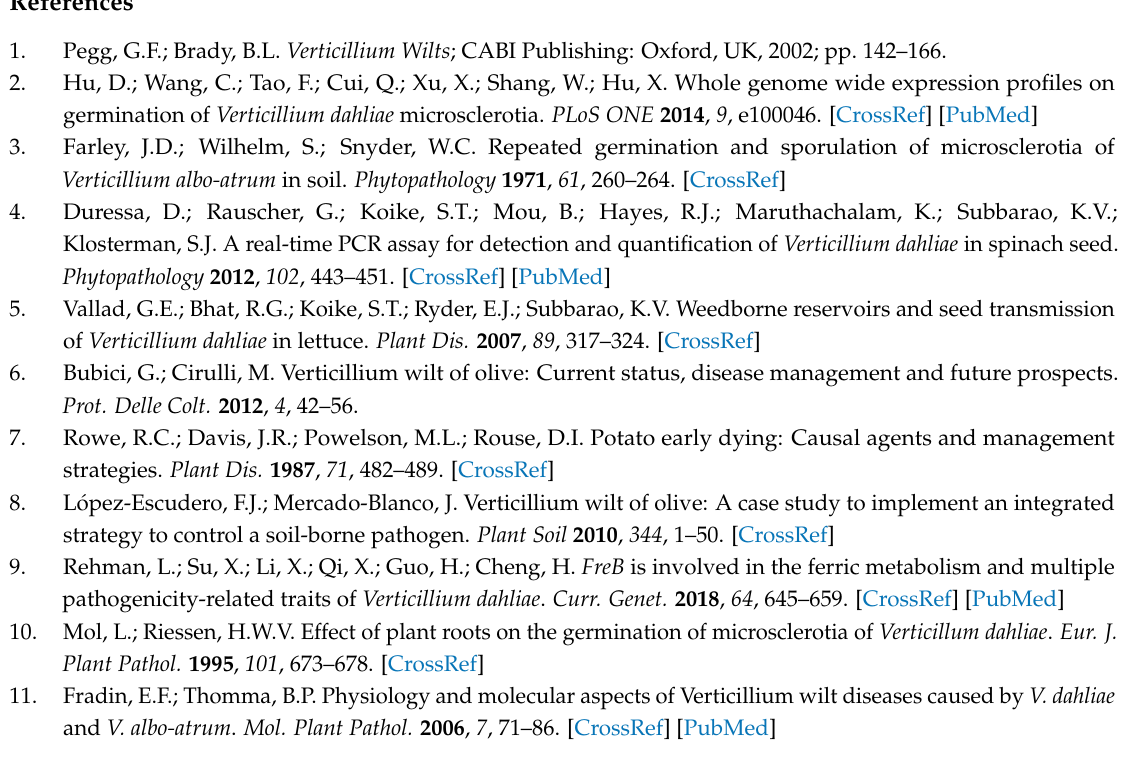
Figure S1. Alignment and amino acid sequences of mCherry sequence. The original and optimized sequences were aligned with the program DNAMAN. Differing nucleotides are represented in red. Figure S2. PCR detection of hpt (549 bp) and mCherry (427 bp) genes, confirming exogenous tDNA integration into V. dahliae genomic DNA. Figure S3. Biological characteristics of Vd-m and Vd-wt . (a) Colony diameter on PDA plates after three, six, nine, and 12 days. (b) Spore production in shake culture on Czapek–Dox medium after four, five, six and seven days. (c) Disease index of N. benthamiana at eight, nine, and 10